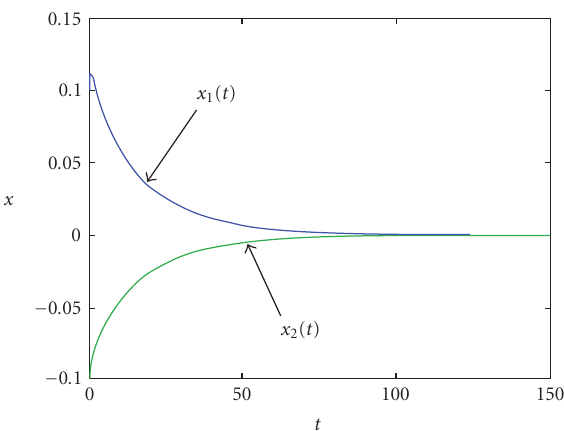
Figure 4.3. Time response of state variable for system (4.1) under a 1 = 1 . 75, a 2 = 0 . 5, b 1 = 0 . 2, b 2 = − 0 . 4, τ = 4 . 761, σ = 0 . 5 τ .